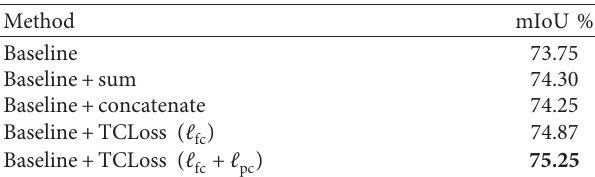
Table 4: Ablation study of feature fusion and propagation on the Cityscapes validation set.